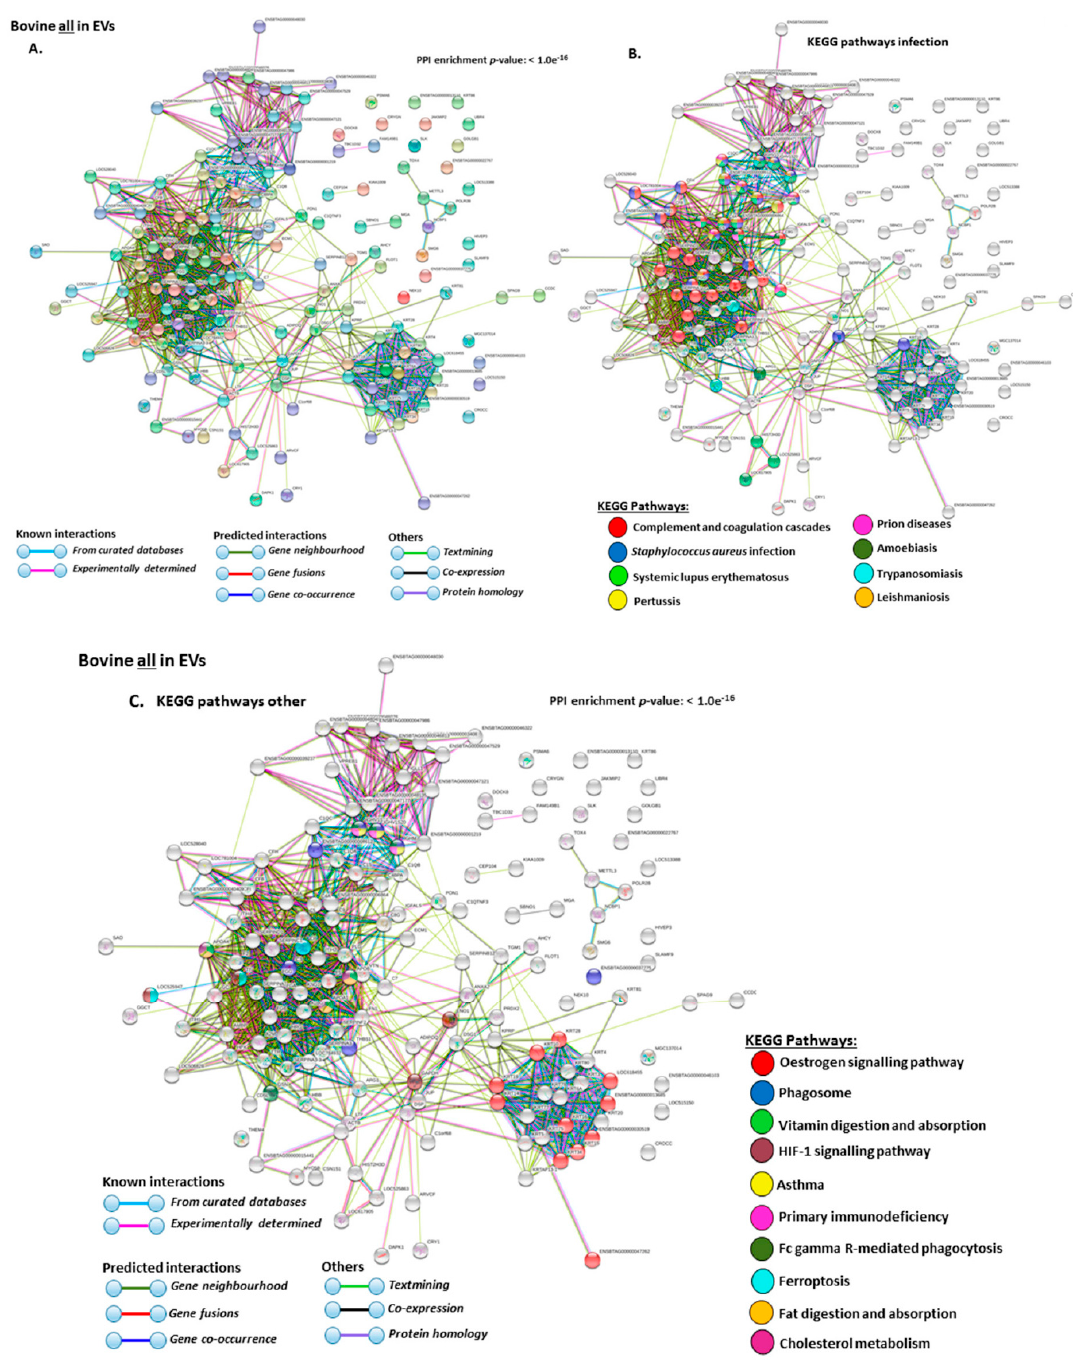
Figure 6. Protein–protein interaction networks of all deiminated proteins identified in serum-EVs of Bos taurus . Protein–protein interactions were reconstructed based on both known and predicted interactions by STRING analysis. ( A ) Query proteins are indicated by the coloured nodes and represent the first shell of interactors. ( B ) KEGG pathways reported in STRING and relating to infection are highlighted (see colour code included in the figure). ( C ) KEGG pathways relating to the identified proteins and reported in STRING are highlighted for other pathways (see colour code included in the figure). The coloured lines highlight which protein interactions are identified through known interactions (this refers to curated databases, experimentally determined), through predicted interactions (this refers to gene neighborhood, gene fusion, gene co-occurrence) or through co-expression, text mining or protein homology (the colour key for connective lines is included in the